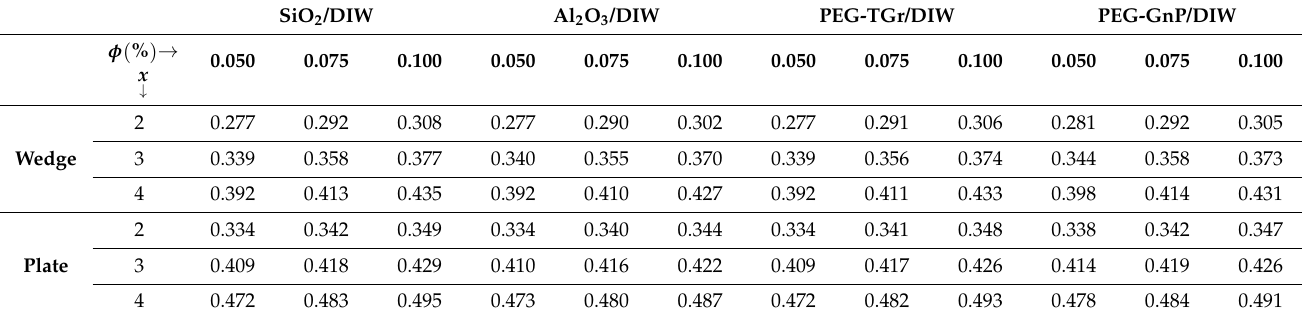
Table 9. Momentum boundary layer thickness 10 × δ M of schematic nanofluids over the wedge and plate at different nanoparticle volume fractions.